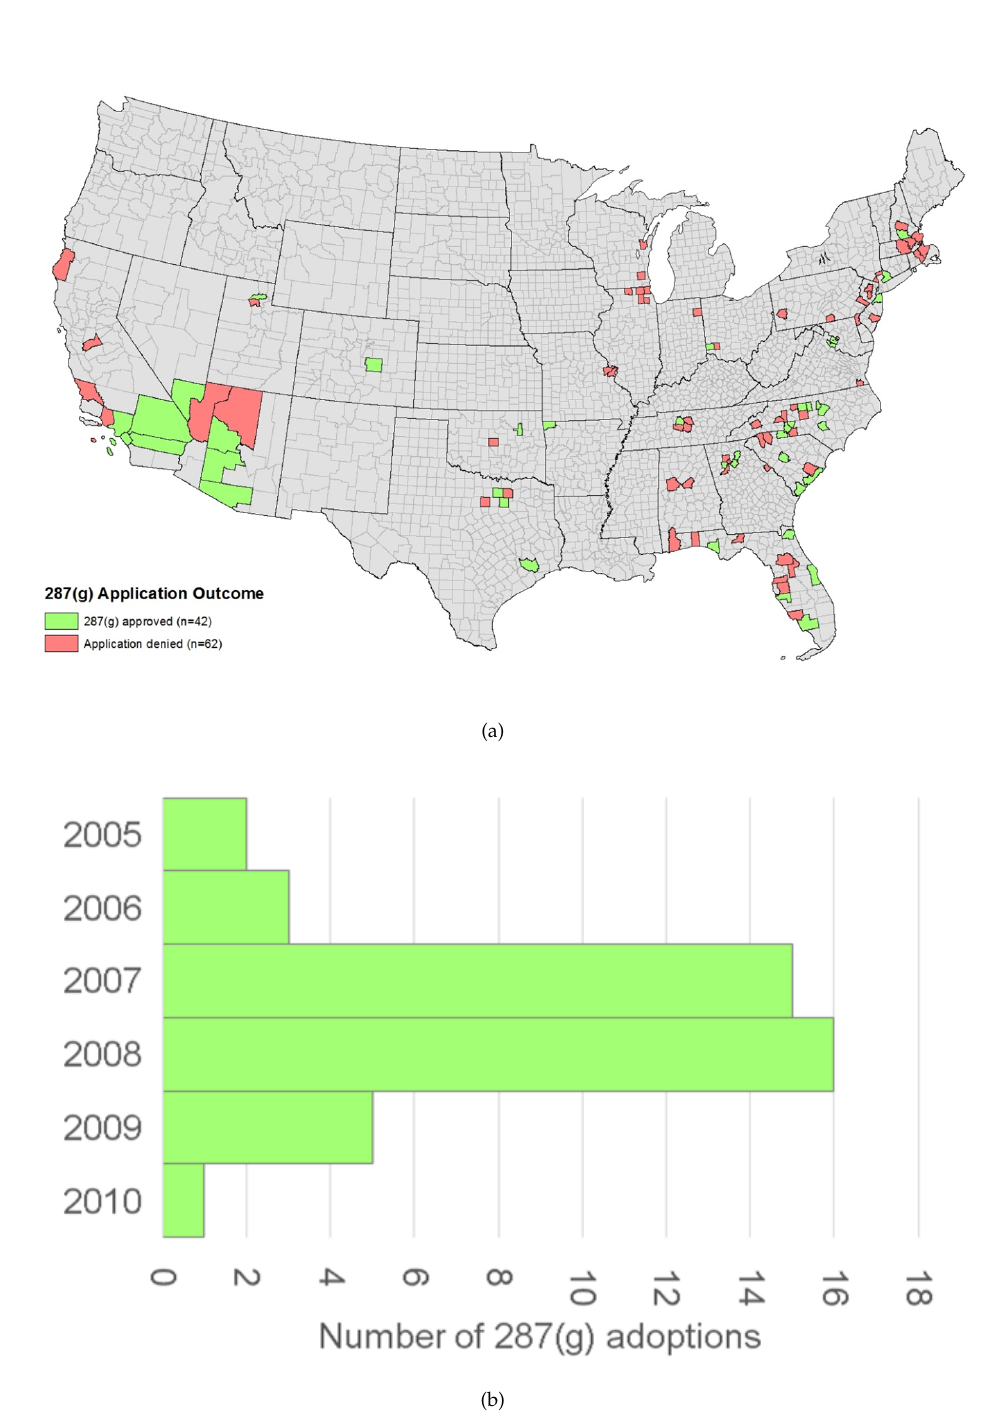
Figure 3: Spatial and temporal variation in 287(g) county applications. Panel A: Counties that applied for 287(g), by application outcome. Panel B: Year of implementation for approved 287(g) counties. Sources: Immigration and Customs Enforcement (2013); Potochnick, Chen, and Perreira (2016). sociological science |